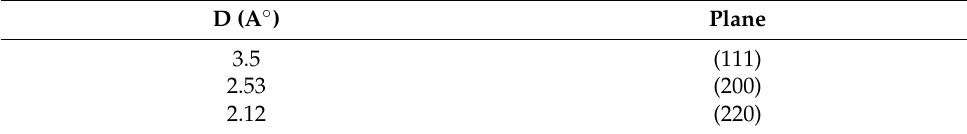
Table 3. D spacing identified by TEM and its corresponding plane.